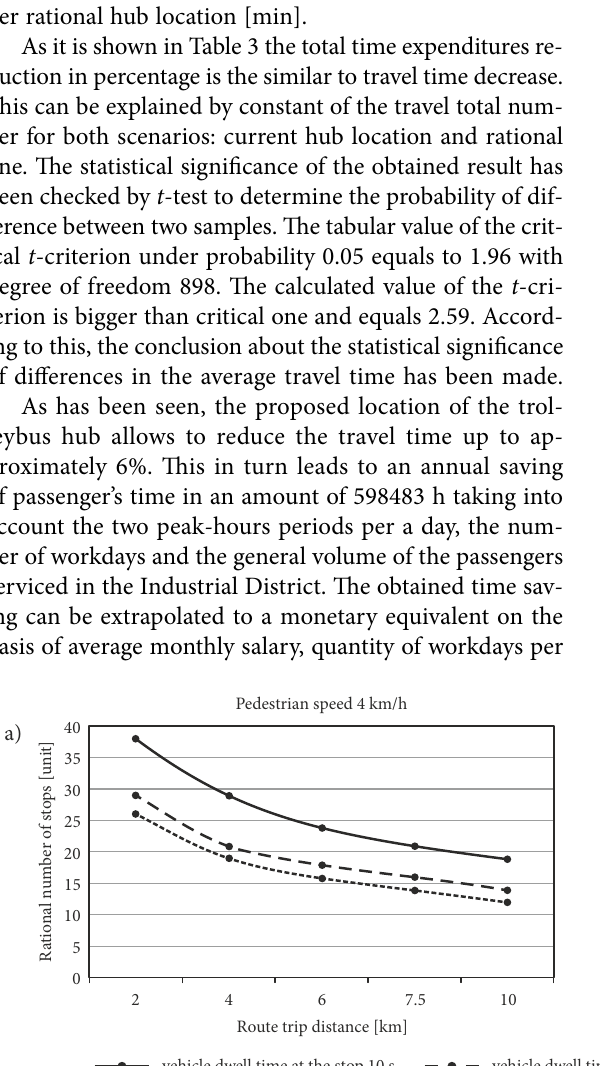
vehicle dwell time at the stop Figure 6. Regularities of rational number of public transport stops variance for the public transit